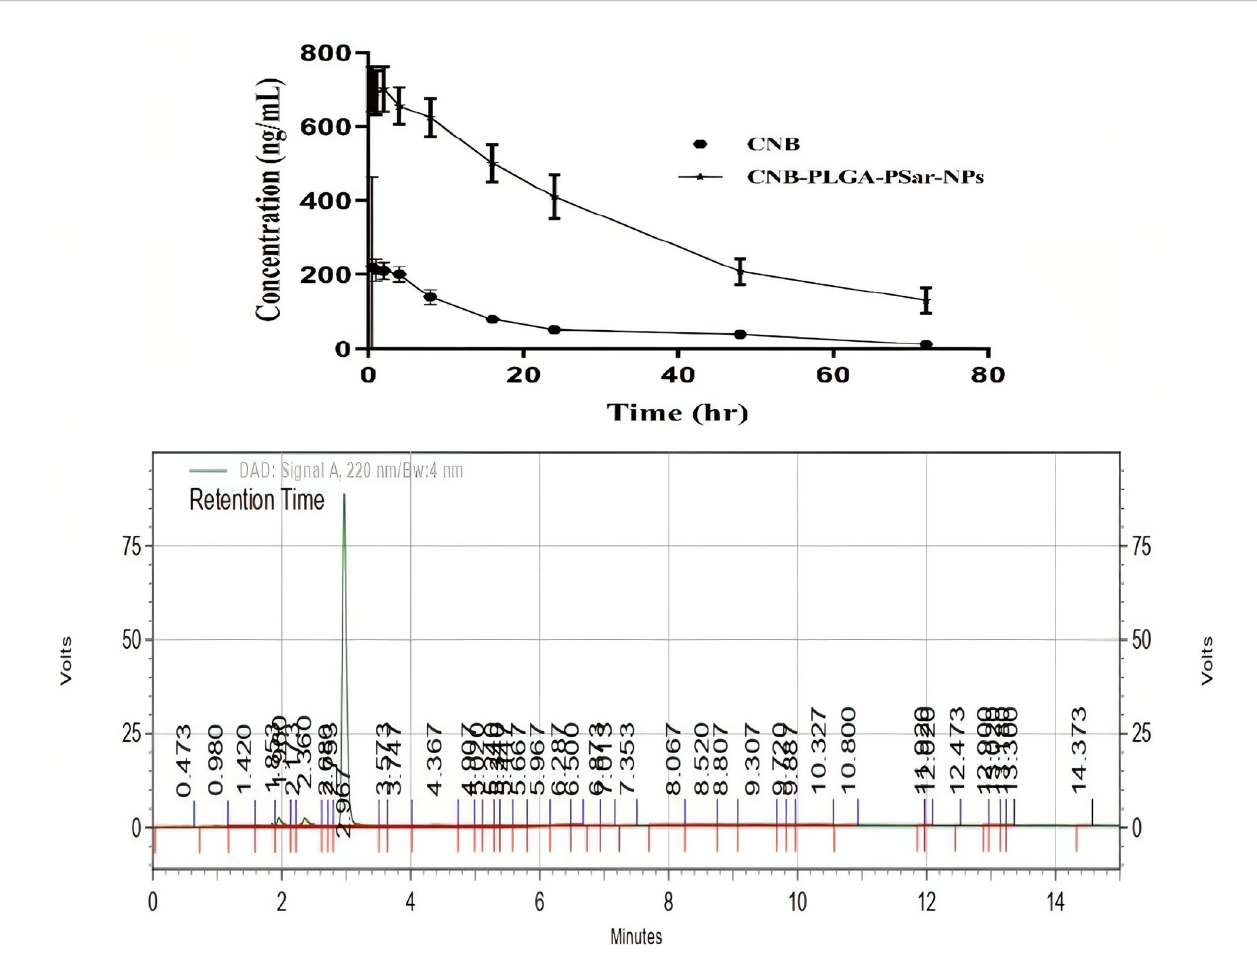
FIGURE 10 Concentration-time pro fi les in plasma of Cabozantinib (CNB) after i.v. bolus administration of CNB suspension and CNB loaded polymeric nanoparticles (CNB-PLGA-PSar-NPs) at 20 mg/kg to 6 male albino Wister rats (200 – 250 g) (n=3). The reverse phase HPLC method was used to fi gure out how much CNB was in the plasma. Put in an HPLC chromatogram showing the amount of CNB in the plasma. The CNB concentration in plasma was determined using reverse phase HPLC. Incorporate the plasma CNB concentration as an HPLC